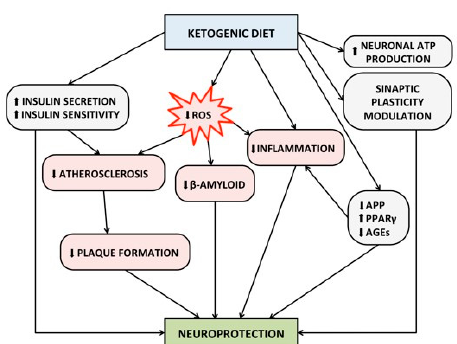
Figure 2. Proposed protective mechanism of ketogenic diet on brain health and cognitive functions. Abbreviations: ATP, Adenosine Triphosphate; AGEs, Advanced Glycosylated End-products; APP, Amyloid Precursor Protein; PPAR- γ , Peroxisome Proliferator-Activated Receptor gamma; ROS,